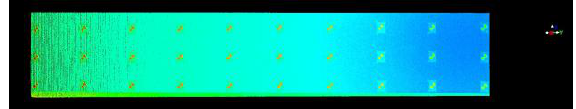
Figure 5. The cropped point cloud of the targets In order to evaluate the influence of the point density on the accuracy and robustness of target localization, we decimate the point cloud via 3D gridding with 5mm-step sample intervals.